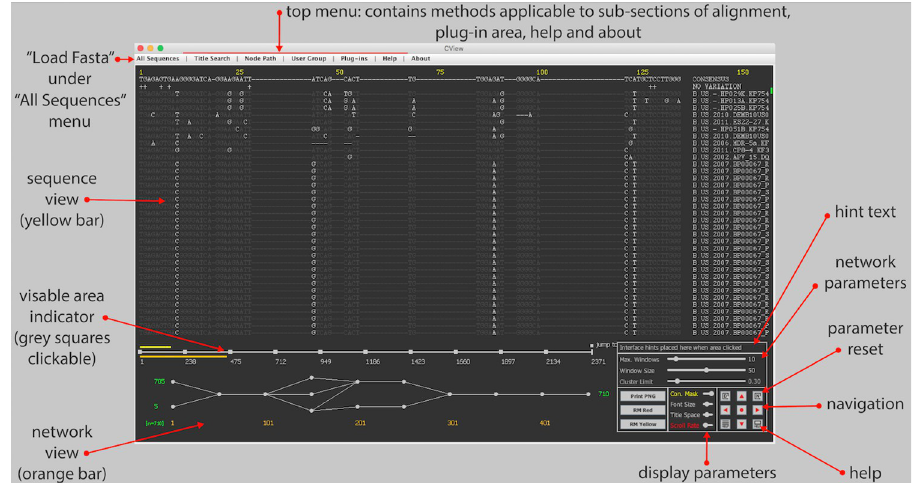
Fig 1. CView interface. The four main areas of the CView interface are depicted. These are sequence view, network view, control panel and the top menu. The yellow numbers on the top indicate the sites of the alignment that are currently in view. These correspond to the yellow bar on the top of the location indicator. The orange numbers along the bottom indicate the locations of the windows that nodes within the network are dependent on. These window locations correspond to the area that the orange bar located the under the location indicator covers. Grey dots indicate selectable nodes within windows. The squares along the location indicator can also be selected in order to jump directly to the indicated co-ordinates. The red text around the outside of the interface summarizes the main features.